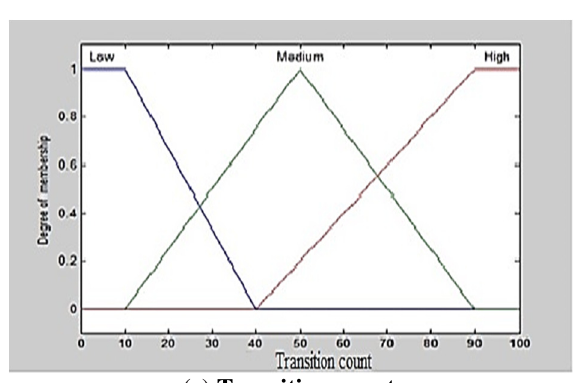
Fig. 6. Functions for fuzzification (a, b,